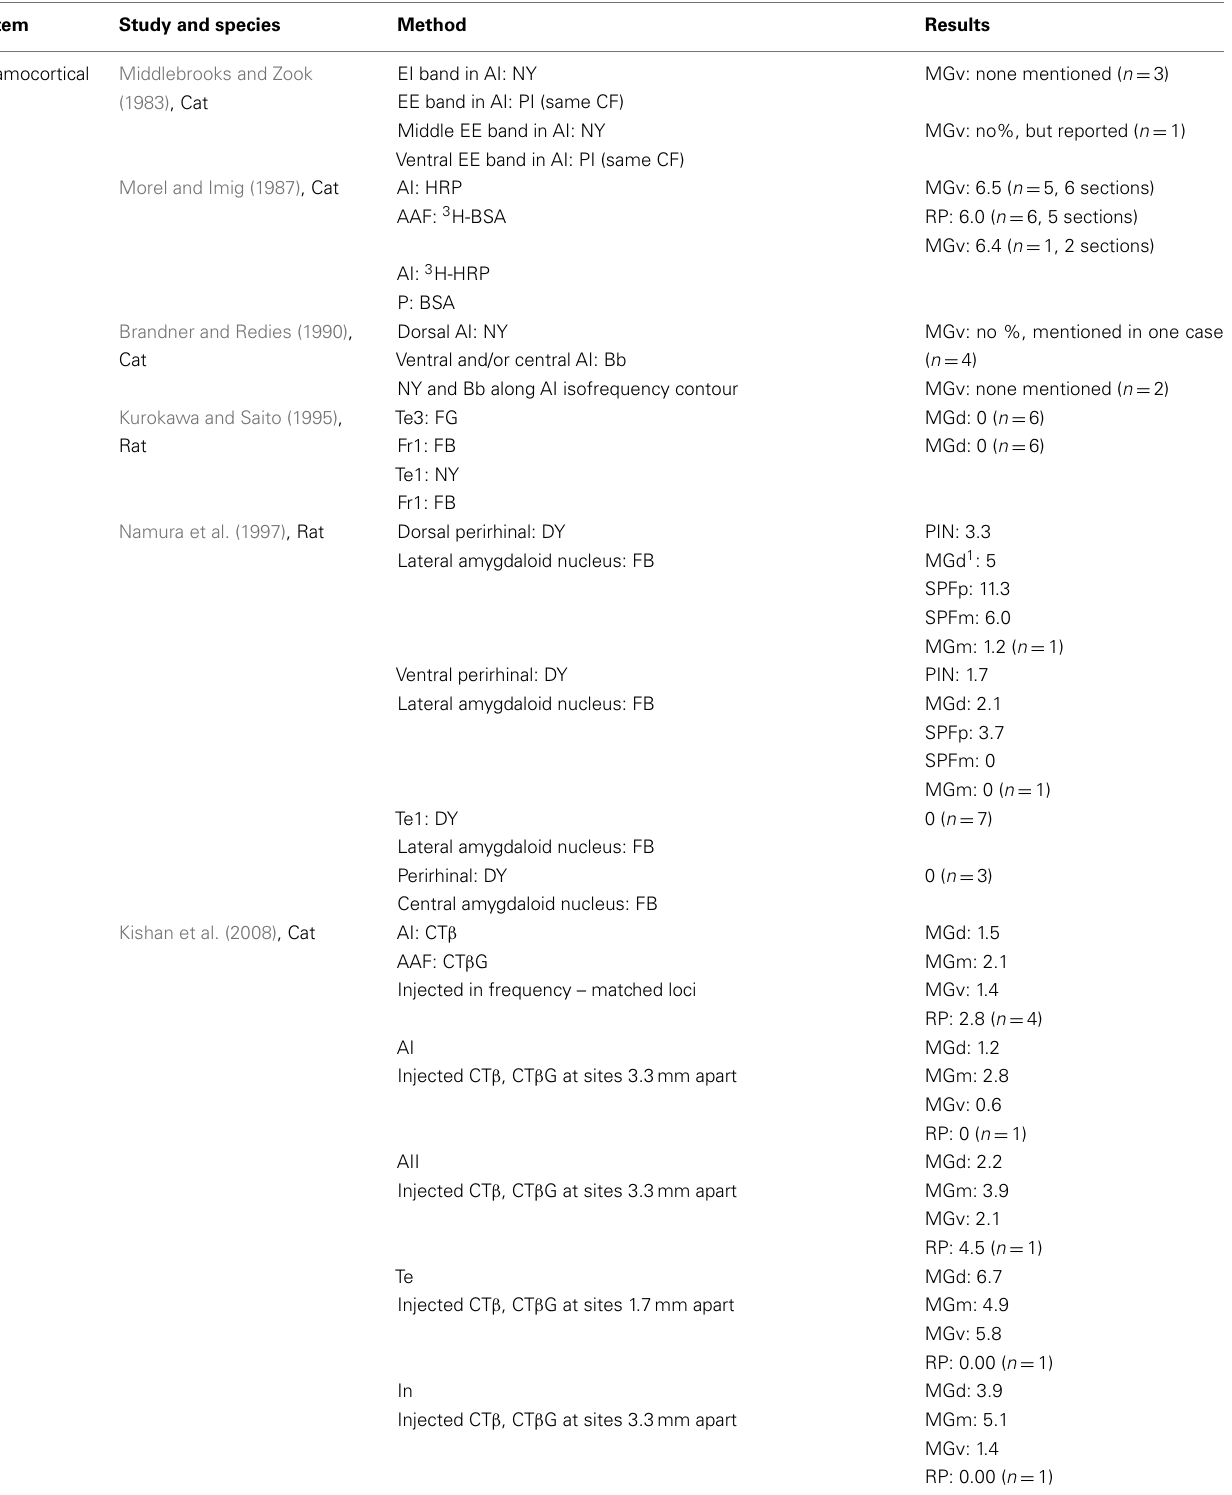
Table 1 | Retrograde studies of auditory branched projections. System Study and species Method Results Thalamocortical Middlebrooks and